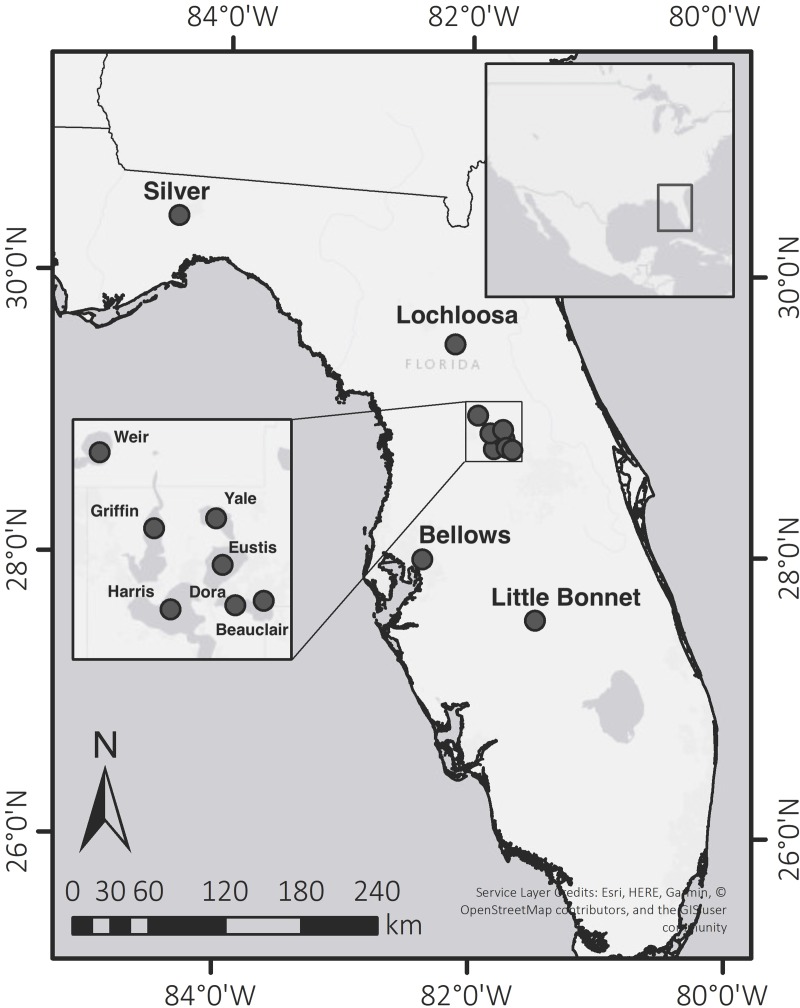
Map showing lake locations in Florida, USA.Inset maps show the entire continental USA and the Harris Chain of Lakes. Base maps include World Light Gray Base [19] and Unites States generalized [20].